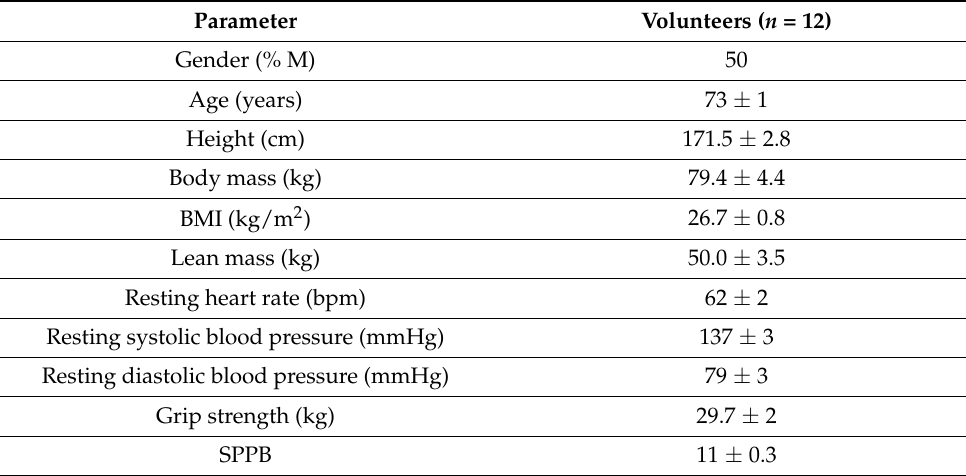
Table 1. Volunteer baseline characteristics (mean ± SEM).